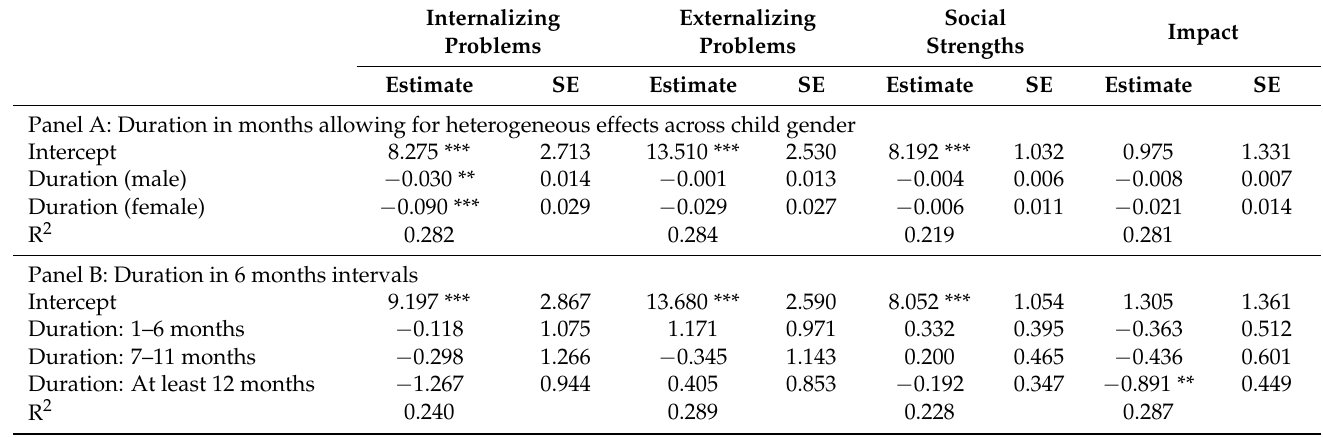
Table 3. Results From Ordinary Least-Squares Regression of SDQ Subscales on Duration of